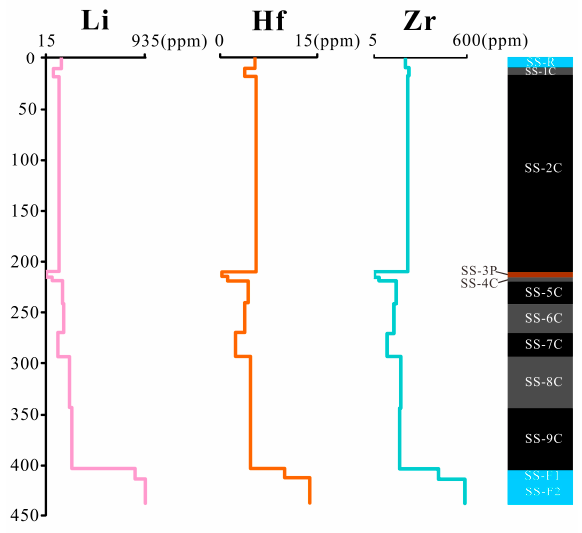
Figure 6. Variations of Li, Hf, and Zr through the seam section.